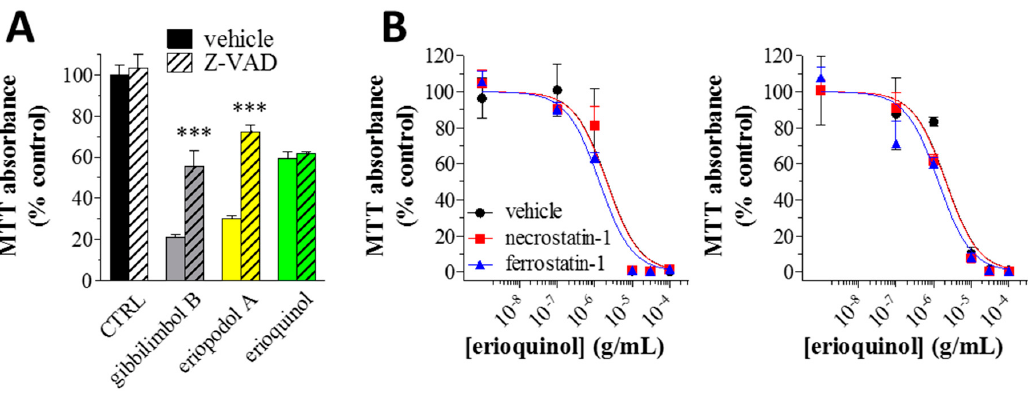
Figure10. Piper genus-derivedcompoundsinducecaspase-dependentandindependentlossofcellviability. ( A ) MCF7 cells were cultured in the absence (CTRL, control) and in the presence of 30 µ g / mL gibbilimbol B / eriopodol A or 10 µ g / mL erioquinol for 6 h, before 3-(4,5-dimethylthiazol-2-yl)-2,5-diphenyltetrazolium bromide (MTT) assay. The pan-caspase inhibitor Z-VAD-(OMe)-FMK (50 µ M) or its vehicle were used as well. Results are expressed by setting the absorbance of the reduced MTT in the CTRL, as 100%. Data are representative of four-twelve independent experiments. *** p < 0.0001 relative to the respective compound alone, i.e., + Z-VAD vehicle. ( B ) MCF7 (left panel) and U373 (right panel) cells were treated with increasing concentrations of erioquinol for 24 h before MTT assay. Erioquinol was administered both in the absence (vehicle) or in the presence of 50 µ M necrostatin-1 and 10 µ M ferrostatin-1 (2 h pre-treatment), a necroptosis and ferroptosis inhibitor, respectively. Results are expressed by setting the absorbance of the reduced MTT in the control samples (absence of erioquinol) as 100%. The data points are representative of four independent